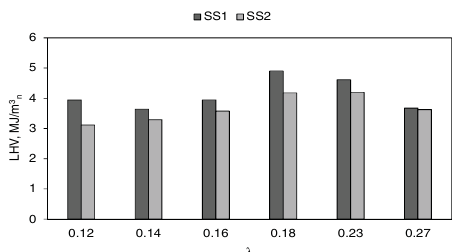
Fig. 3. LHV of the gasi fi cation gas versus air ratio.